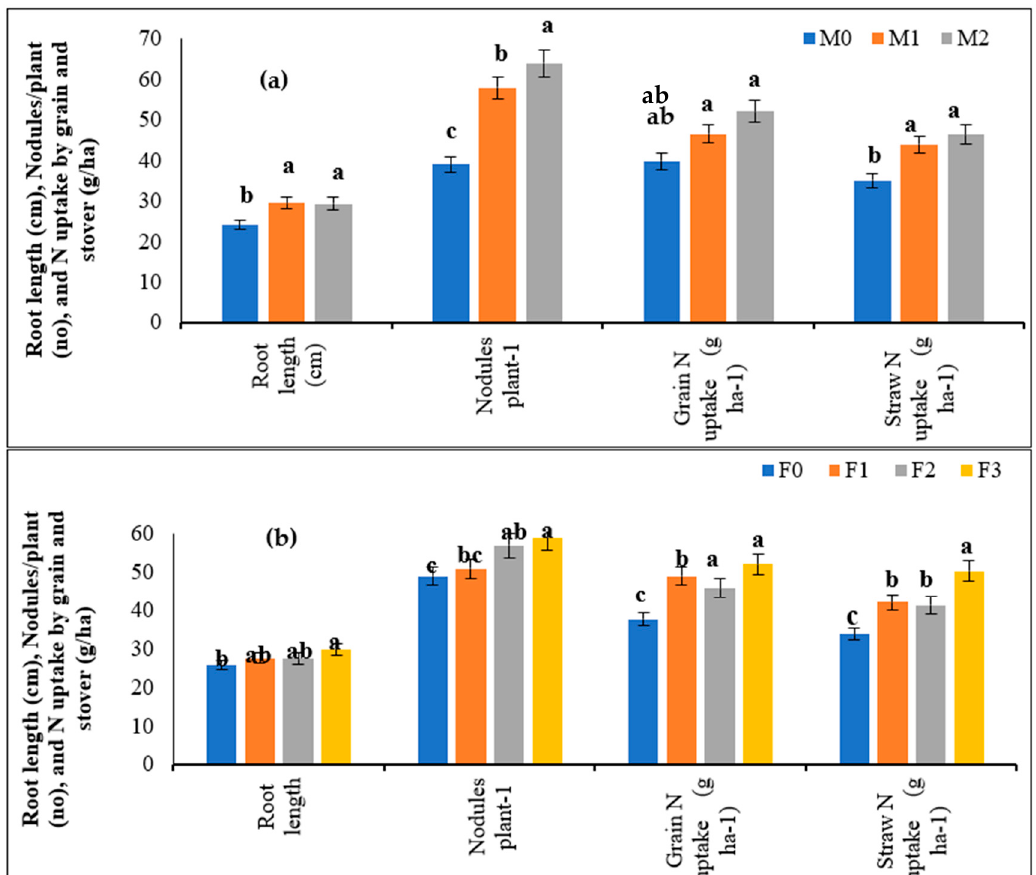
Figure 4. ( a ) Effect of different methods of Mo and ( b ) Fe and Zn application on root length, nodules plant − 1 , N uptake in grain and stover yield of cowpea. The column representing the mean with a similar or dissimilar letter(s) was evaluated with the least significant difference (LSD) multiple range tests using a probability level of p ≤ 0.05 along with standard deviation.